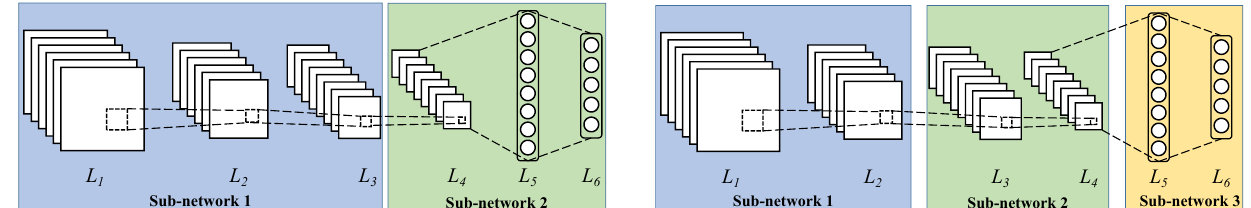
Figure 7. Two schemes to partition the SNN into multiple